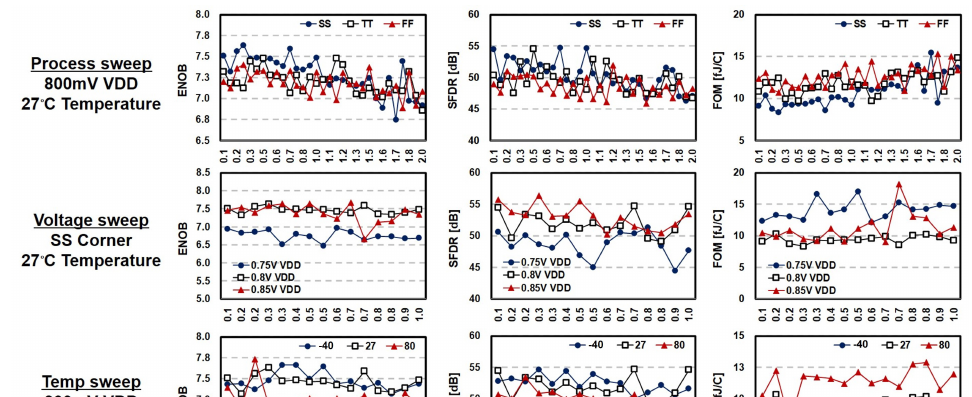
Figure 10. Performance plots.